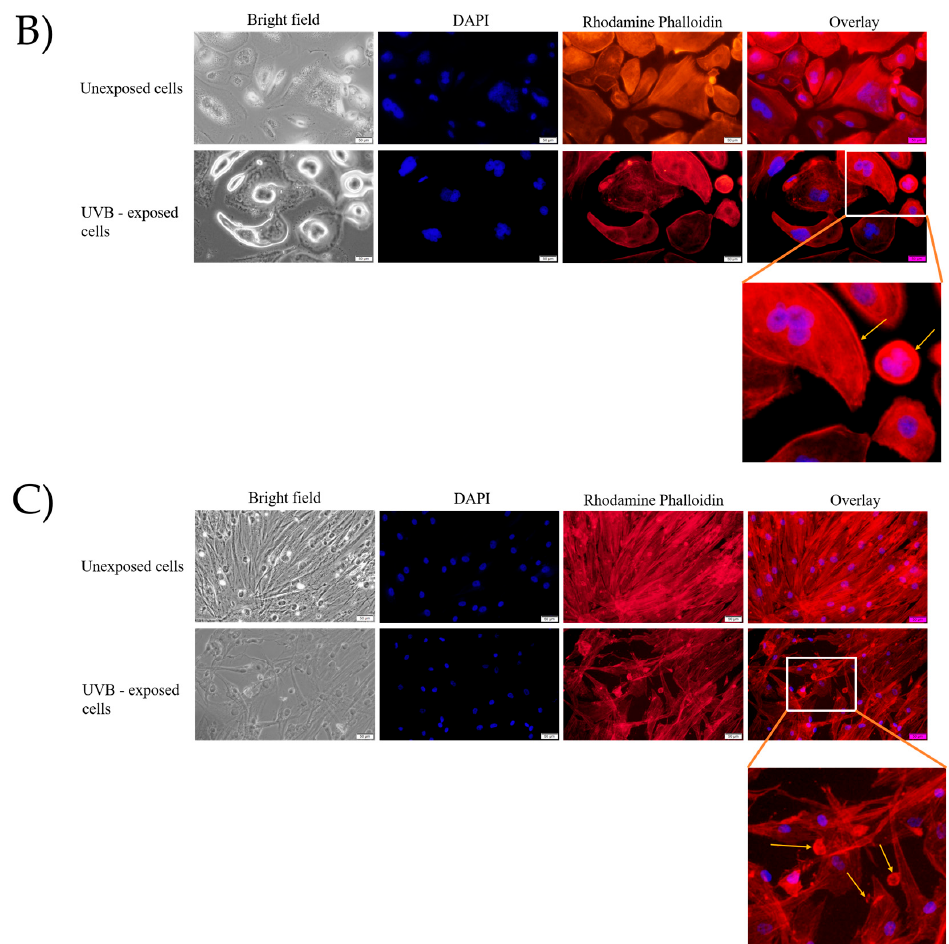
Figure 5. ( A ) Detroit-562 cells, ( B ) SCC4 cells, and ( C ) HGF cells visualized by fl uorescence microscopy, after exposure to UVB 5 J/cm 2 . The impact of UVB radiation on the nuclei is shown by DAPI staining (blue) and, for the F-actin fi bers, rhodamine phalloidin (red). The yellow arrows highlight the apoptotic-like changes. The scale bar indicates 50 µm.